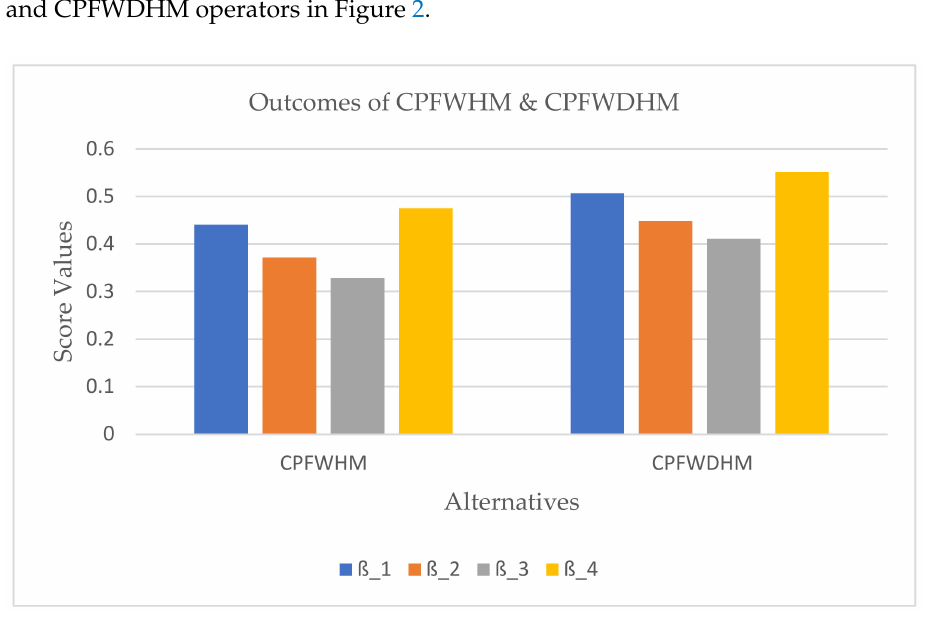
Figure 2. Score values of tourist destinations.